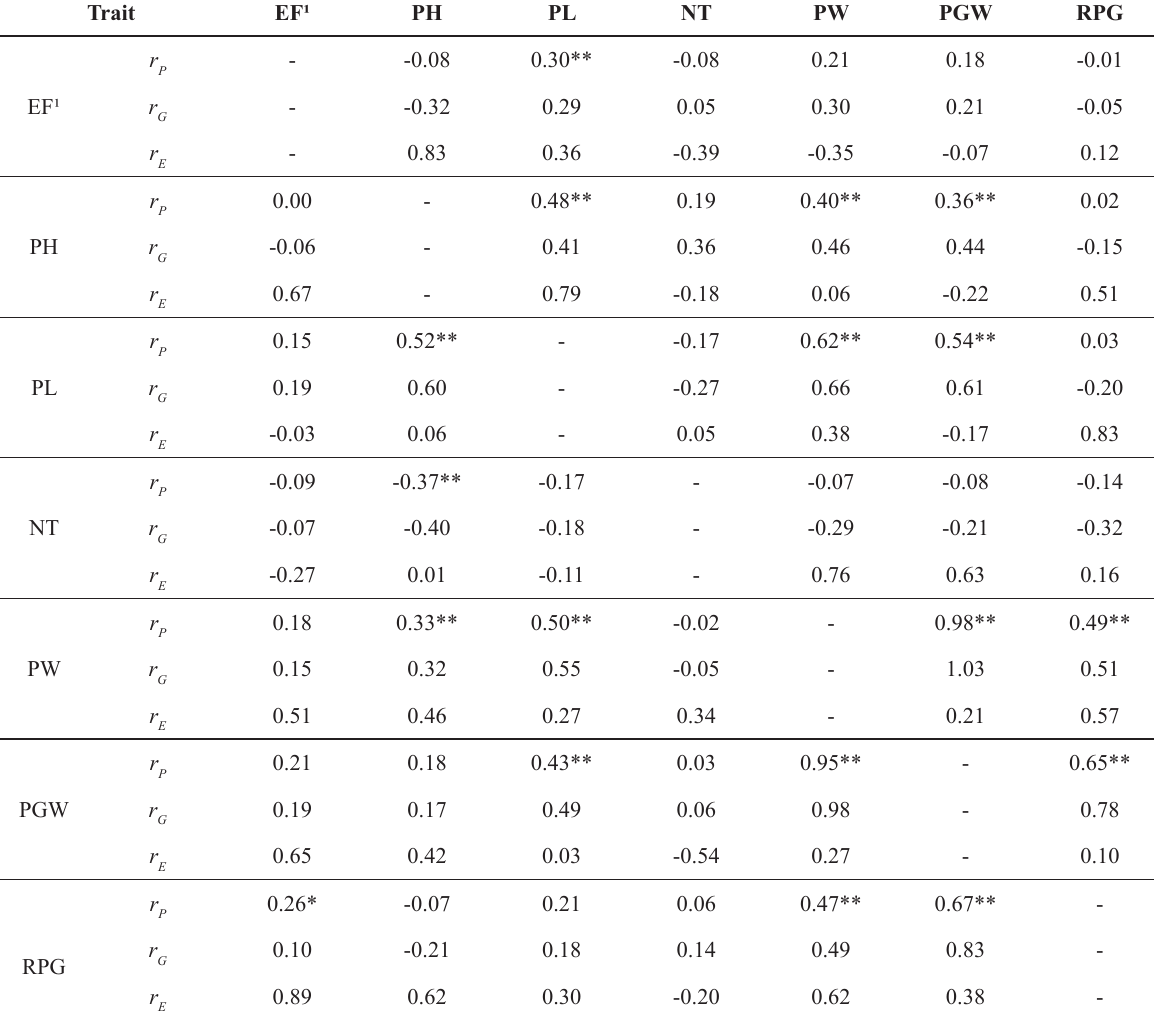
Estimatives of phenotypic ( r black oat families evaluated in 2016 (upper diagonal) and 2017 (inferior diagonal) crop seasons.